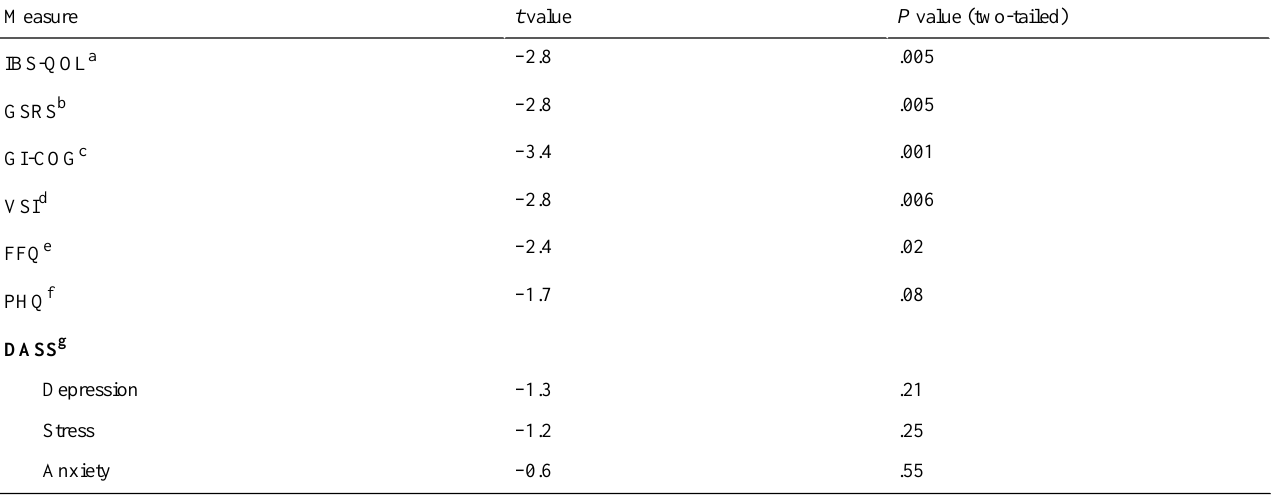
Table 2. Significance of treatment allocation at 8 weeks using multiple imputation.